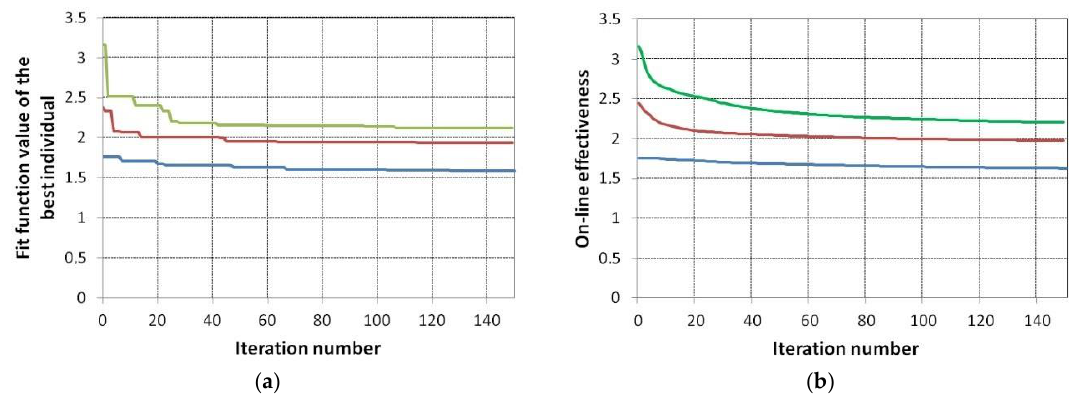
Figure 9. Changes in: ( a ) the best individual’s adaptation function, ( b ) χ on-line e ff ectiveness in function of the iteration number (generation) for sample optimization processes of a PV-wind hybrid system.